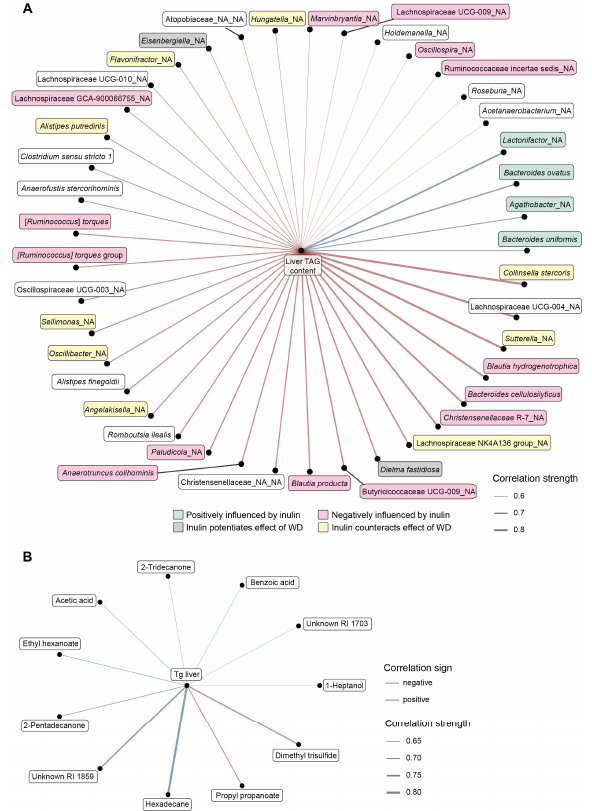
Figure 7. Correlation network between liver TAG content and cecum microbiome ( A ) and VOCs ( B ) composition . The edge width and color are proportional to the value of the correlation (red: positive; blue: negative). RI, retention index.